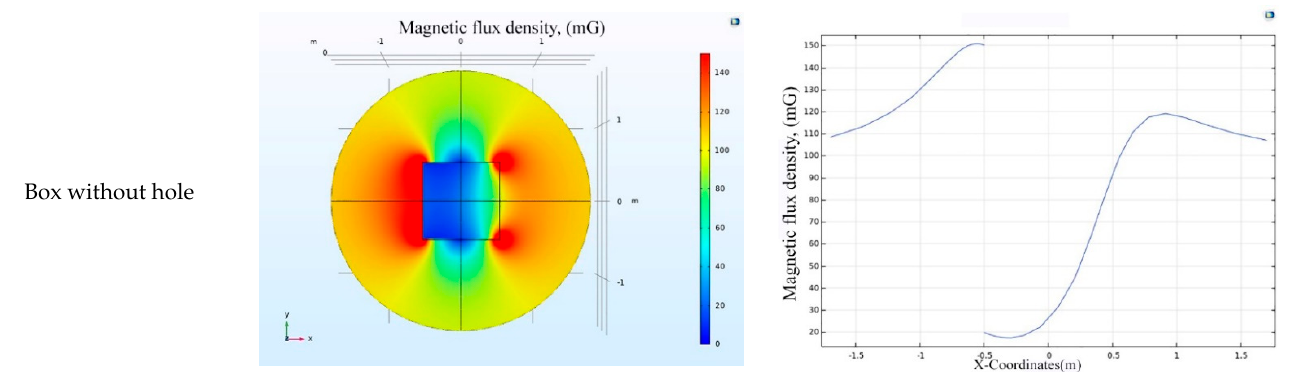
Table 5. The effect of the direct current in the MSR.